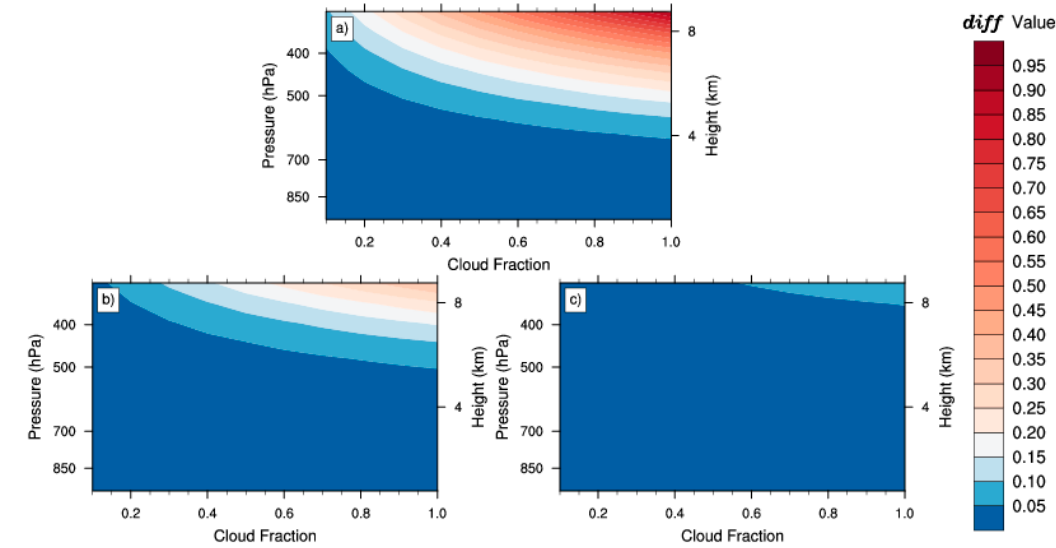
Figure 4. Difference between cloudy and clear sky radiance with changes in the cloud fraction and cloud top height at (a) 54.4 GHz, (b) 54.94 GHz and (c) 55.5 GHz.